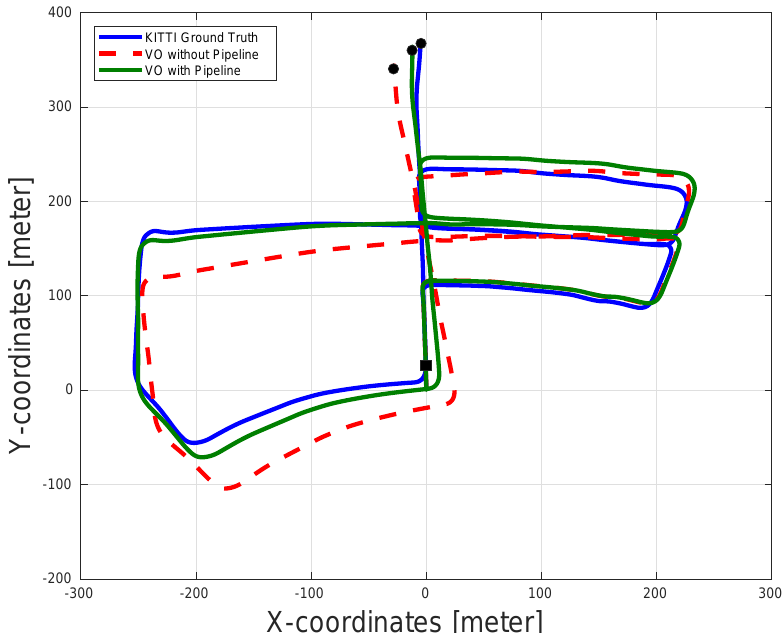
Figure 7. The pose estimation results of sequence 5 in the KITTI dataset with and without the pipeline, along with the dataset ground-truth. The performance of the VO with the pipeline enhances the performance of the VO in both translation and orientation estimation. This is not reflected in the average RMSE of the sequence due to the drift in the orientation of the VO without the pipeline, which causes some estimated poses to look close to the ground truth, although the overall estimated trajectory is much worse. The black square represents the start of the paths and the black circles represent the ends of the paths.